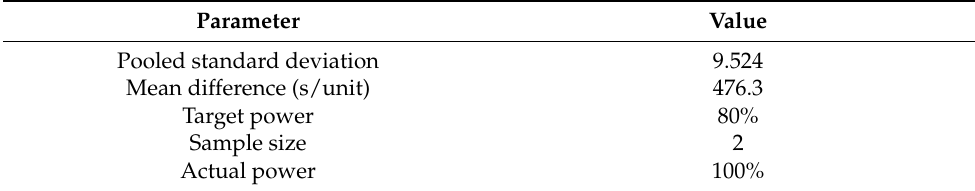
Table 11. Sample size estimation by Minitab.